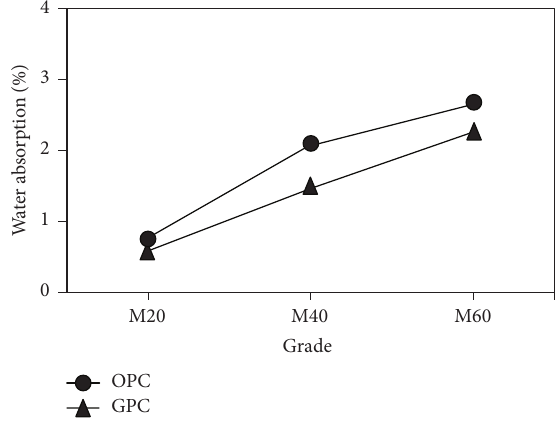
Figure 2: Water absorption for OPC and